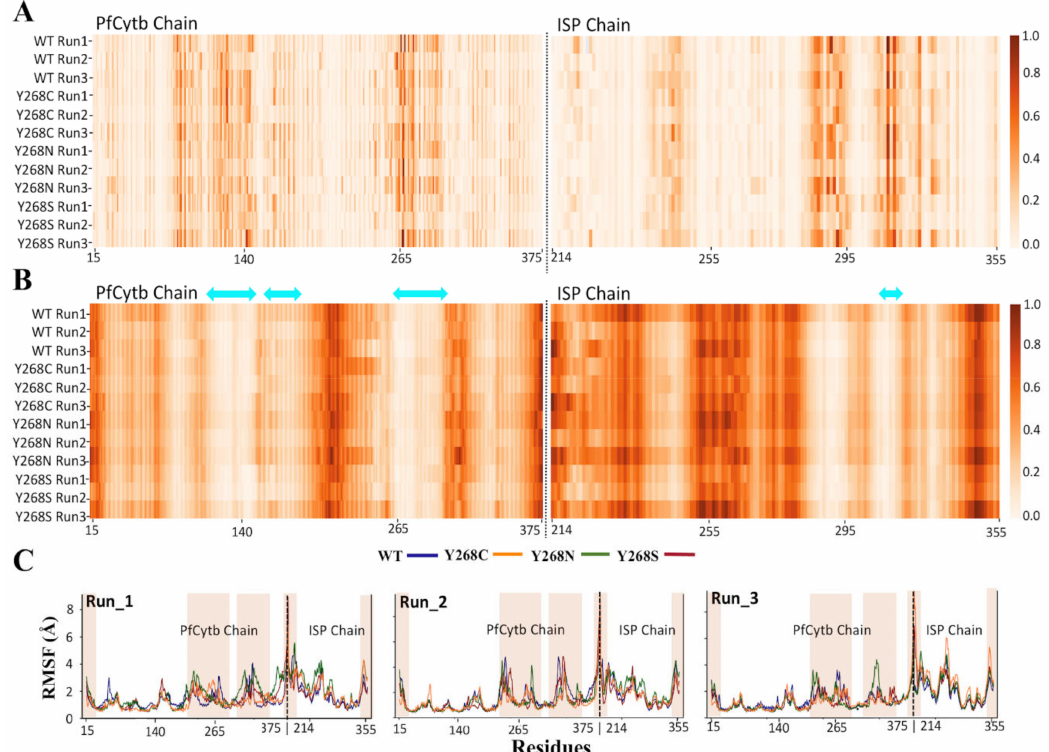
Figure 9. Dynamic residue network (DRN) analysis. Heat map representation of normalized values of ( A ) Betweenness centrality (BC) and ( B ) Average shortest path (L) for PfCytb and ISP chains. L values were correlated with root mean square fluctuation (RMSF) which is plotted in ( C ) where the WT (wild-type) and mutant systems Y268C, Y268N and Y268S are represented by the blue, orange, green and red lines, respectively. ( C ). Black dotted lines in RMSF plots show an intersection between the two chains. Two-sided cyan arrow on the L heat map represents active site residues. Each protein system had triplicate runs presented in ( A – C